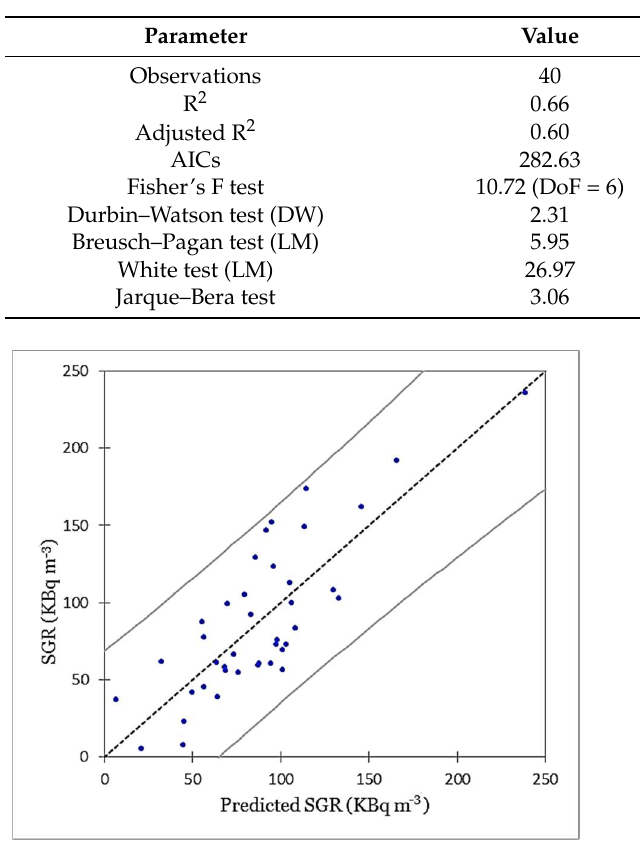
Table 3. Descriptive statistics of extracted airborne radiometric.